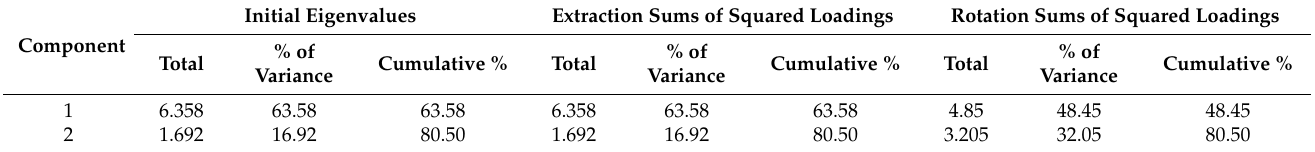
Table 5. Variance explained by WAS components.